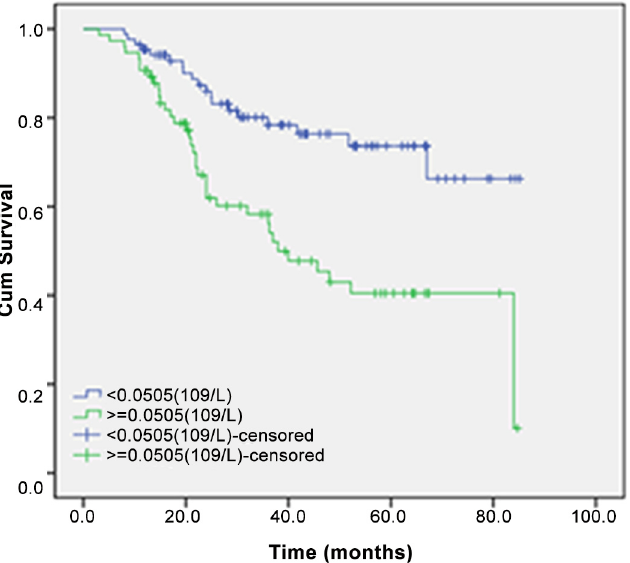
Fig 2. OS curve grouped by preoperative monocyte count. Patients with high preoperative monocyte count ( (cid:1) 0.505) had a significantly poorer OS than those with low preoperative monocyte count ( < 0.505) ( P < .001).